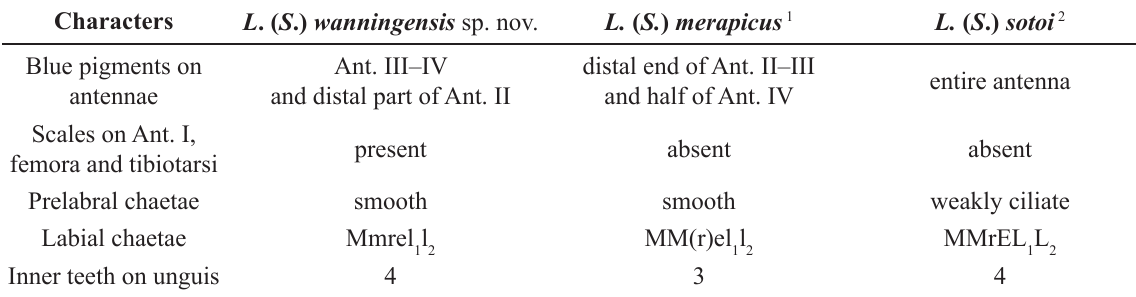
Table 3. Comparison of Lepidocyrtus ( Setogaster ) wanningensis sp. nov., L . ( S .) merapicus Yoshii & Suhardjono, 1989 and L. ( S. ) sotoi Bellini & Godeiro,